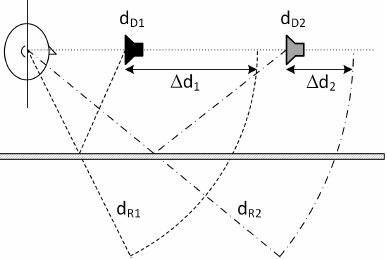
Figure 5. Principle of the distance dependency of the initial time delay gap (ITDG), with d Dx . . . distance of direct sound, d Rx . . . distance of reflection, ∆ d x . . . distance of the ITDG; (after